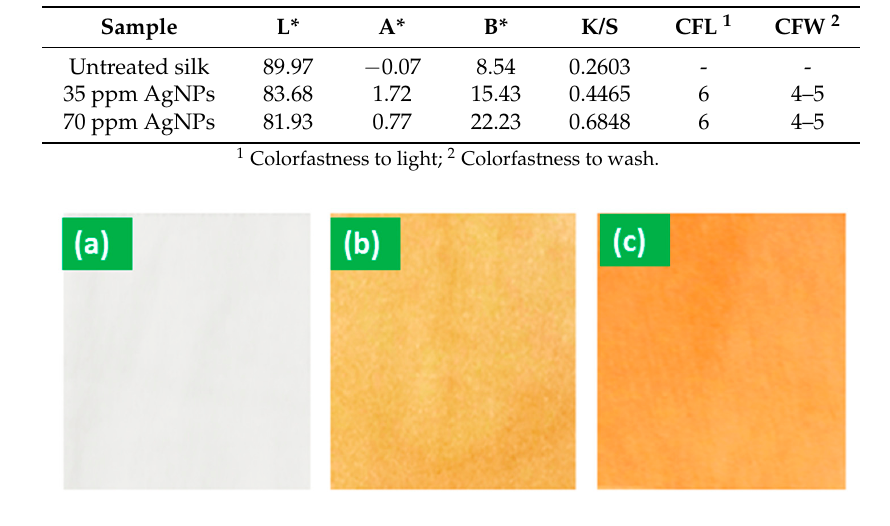
Figure 7. Photographs of ( a ) control silk, and AgNPs-treated fabric with ( b ) 35 ppm and ( c ) 70 ppm.